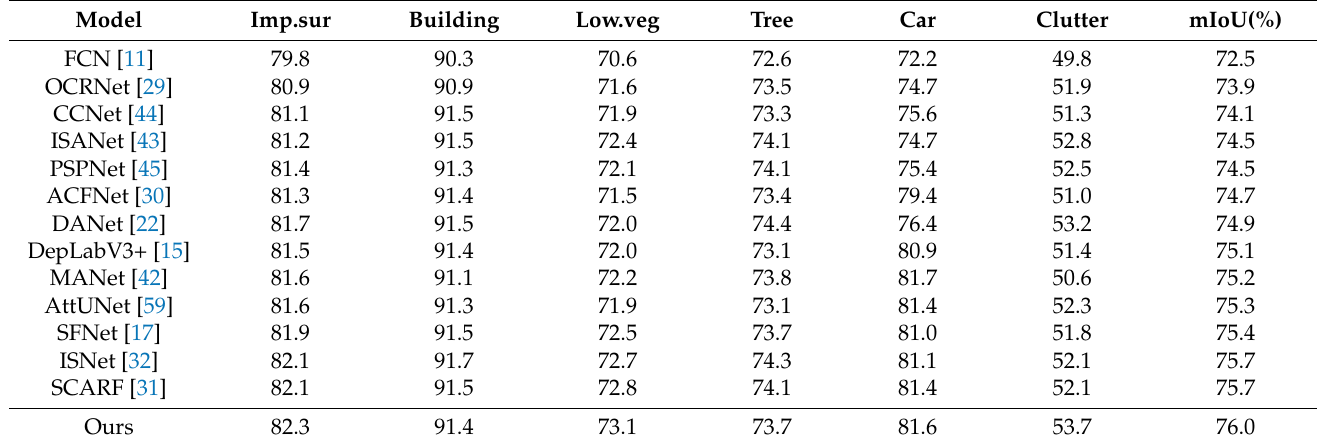
Table 6. Per-class results (mean intersection over union) on the Potsdam test